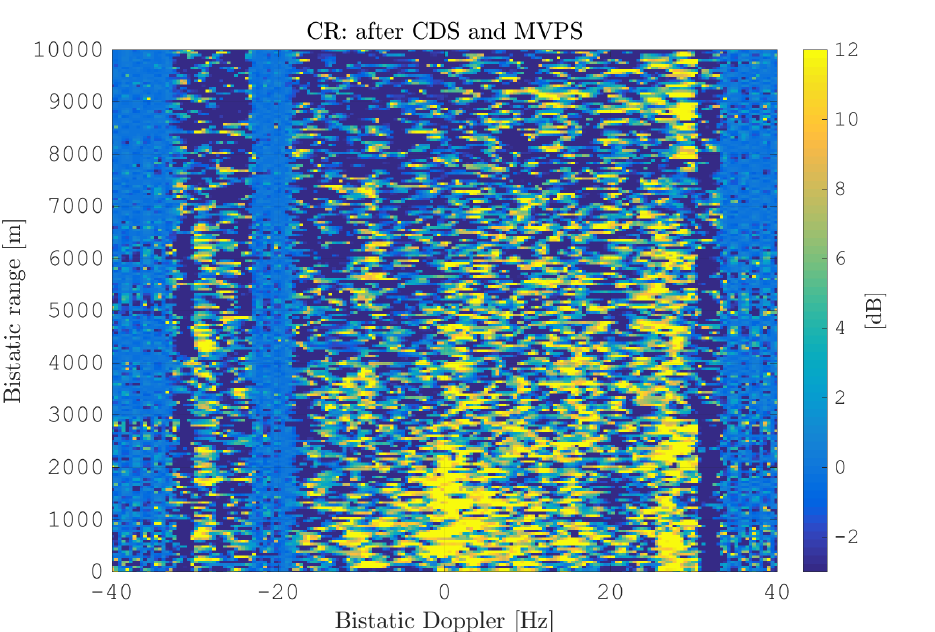
Figure 20. Cancellation ratio between range-Doppler maps after DPCA application: between calibra- tion with CDS (Figure 14) and calibration with MVPS (Figure